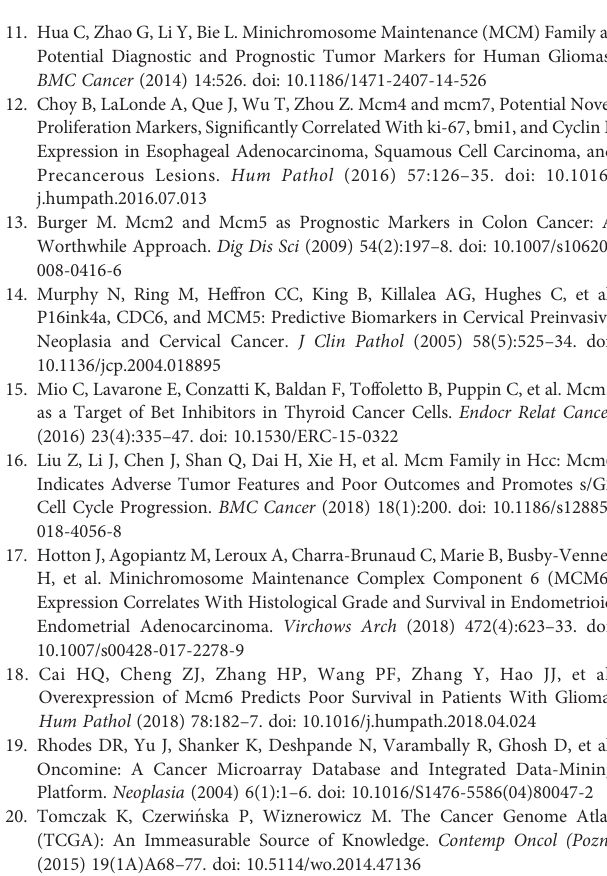
Supplementary Figure 1 | (A) Expression of miR-23b-3p and miR-34a-5p in A2780 cells transfected with miR-23b-3p mimics or miR-34a-5p mimics was evaluated by RT − qPCR, respectively. (B) Expression of MCM2, MCM3, MCM4, MCM5, MCM6, and MCM7 in A2780 cells transfected with miR-23b-3p mimics or miR-34a-5p mimics was evaluated by RT − qPCR, respectively. Supplementary Figure 2 | Protein phosphorylation analysis using CPTAC database for MCMs. Supplementary Figure 3 | CTRP drug sensitivity analysis using the GSCALite database for MCMs. Supplementary Figure 4 | GDSC drug sensitivity analysis using the GSCALite database for